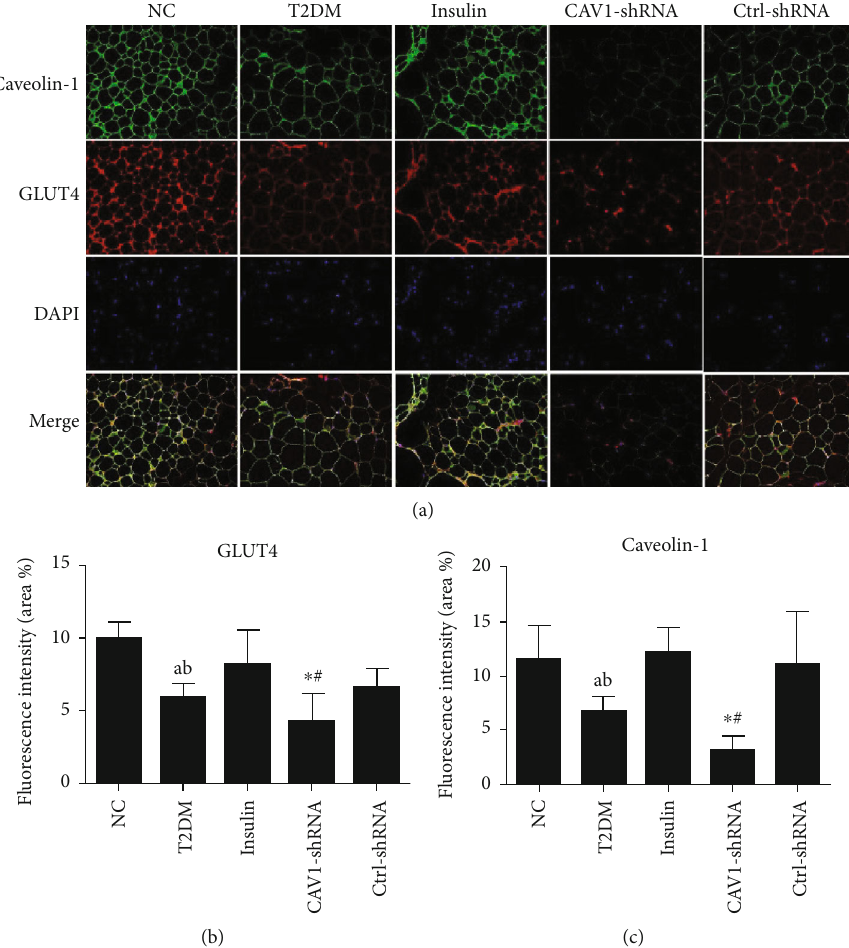
Figure 7: Immuno fl uorescence results of the visceral adipose tissue from all fi ve groups. Representatives of fl uorescent microscope images stained with Caveolin-1 (green), GLUT4 (red), and DAPI (blue). Images of the adipose tissue were taken using a microscope under 20x objective lens (data are expressed as mean ± SEM . ∗ P < 0 : 05 compared with the insulin group. # P < 0 : 05 compared with the Ctrl-shRNA group, a represents P < 0 : 05 compared with the NC group, and b represents P < 0 : 05 compared with the insulin, n = 5